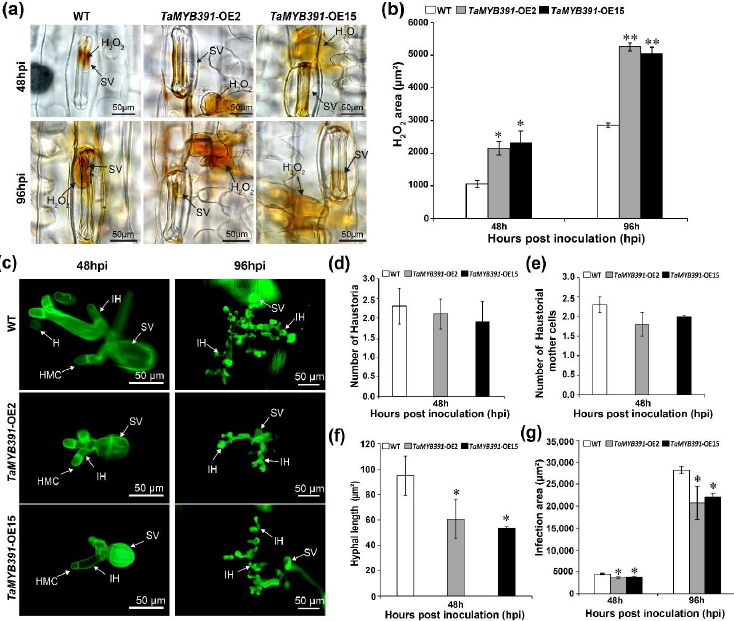
Figure 6. The overexpression of TaMYB391 improves wheat resistance to the virulent Pst race CYR31, while Pst growth is diminished. ( a ) H 2 O 2 accumulation around the infection site was detected under a BX-51 microscope (Olympus, Tokyo, Japan). For H 2 O 2 burst detection, wheat leaves inoculated with Pst CYR31 were sampled at 48 and 96 hpi. These samples were then stained with 3,3-diamino- benzidine (DAB). SV, substomatal vesicle; ( b ) H 2 O 2 accumulation was quantified using DP-BSW software (Olympus, Tokyo, Japan) by measuring the area where DAB is accumulated at the infection site. ( c ) Fungal structures in TaMYB391 -overexpressing and control plants challenged with the virulent Pst race CYR31. Leaves inoculated with Pst were sampled at 48 and 96 hpi. Samples were then stained with wheat germ agglutinin (WGA) and fungal growth was detected using an Olympus BX-51 microscope (Olympus, Tokyo, Japan). SV, substomatal vesicle; HMC, haustorial mother cell; IH, infection hypha; H, haustoria. ( d ) The average number of haustoria per infection site. ( e ) Average number of haustorial mother cells per infection site. ( f ) Hyphal length as measured from the juncture of the hypha and substomatal vesicle to the tip of the hypha. ( g ) The colony area per each infection site. Data were computed from three biological replications and 50 infection sites. Values represent the means ± SEs. The significant difference between TaMYB391 -overexpressing and control plants is indicated by asterisks, which was estimated using Student’s t -test. *, p < 0.05; **, p <